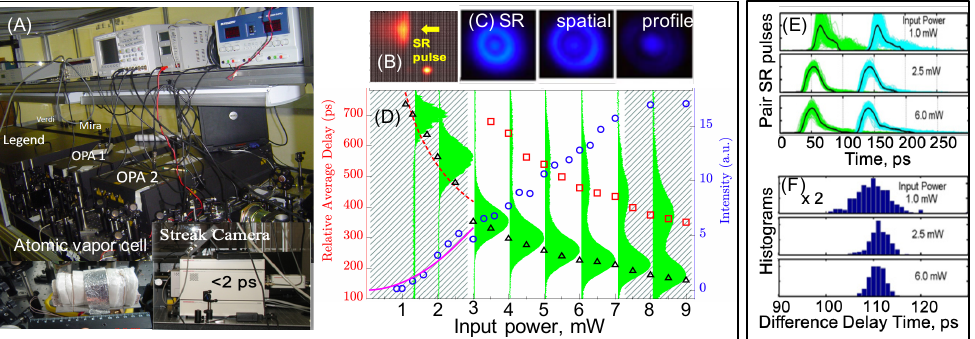
Figure 2. ( A ) A typical experimental setup for superradiance. A femtosecond laser system is used to excite a heated-up atomic vapor. The emitted superradiance pulses are detected by a picosecond streak camera. ( B ) A typical temporal profile of the recorded picosecond superradiance pulse relative to the reference pulse. ( C ) Spatial beam profiles of the superradiance light on a paper screen far away from the sample. For higher excitation power, the conical emissions are formed because of multiple transverse modes involved in the overall process. For lower power, superradiance emission is directional originating from a cigar-shaped sample. ( D ) Superradiance time delays and peak intensities as functions of input power. As power increases, delay time decreases, whereas peak intensity increases nonlinearly. In this particular case, pairs of superradiance pulses, originating from two macroscopically extended groups of atoms, are recorded. ( E ) To measure fluctuations in delay times, which have quantum mechanical origin, pairs of pulses are needed to obtain relative delays for each laser shot. ( F ) Distributions of time delay